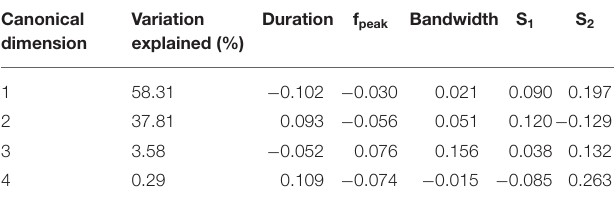
TABLE 3 | Loading scores of call duration, peak frequency (f peak ), bandwidth, average slope of the first half of the call (S 1 ) and average slope of the second half of the call (S 2 ) contributing to the canonical dimensions used to discriminate call types within Nycticeius humeralis and percentage of variation explained by each